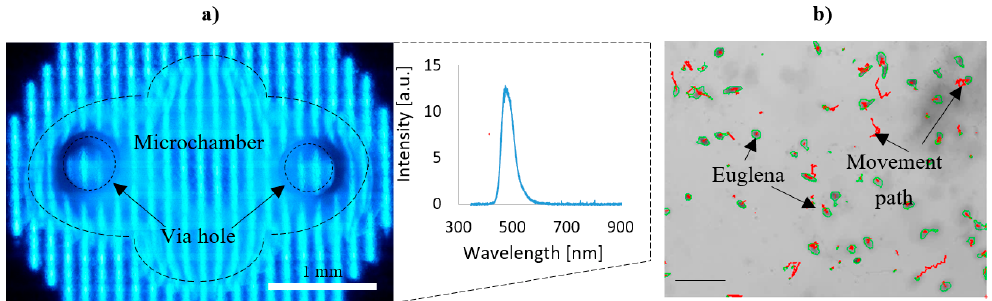
Figure 6. Study on E. gracilis phototaxis on the LOC platform: ( a ) view of the OLED illuminated microchamber with spectrum characteristics (blue color, 470 nm), ( b ) microscopic image of E. gracilis response to this illumination—visible rotational movements detected by the software. Luminance was set to 100 Cd / m 2 for each test. Scale bar—100 µ